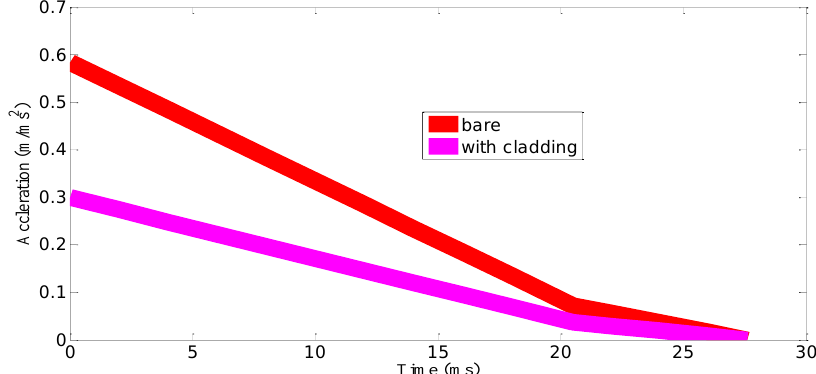
(c): Response of blast load on front wall alongacceleration with and without cladding material. Fig.14. Response of the SDOF with cladding material subjected to blast load on front